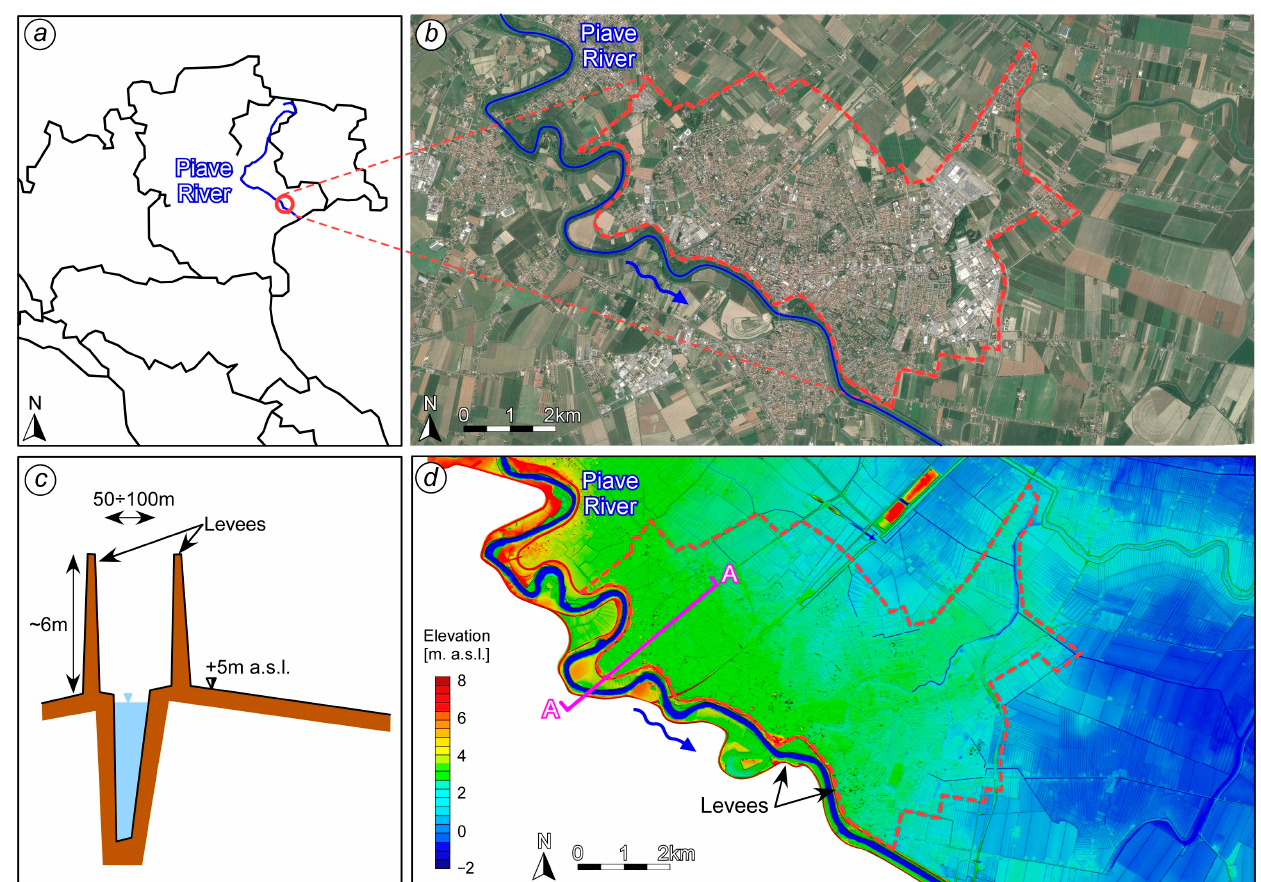
Figure 1. Study area: ( a ) location in the north of Italy; ( b ) aerial view of the study area in the San Donà di Piave Municipality with the course of the Piave River in blue; ( c ) schematic of cross-section A-A (out of scale); ( d ) the DTM with elevations in meters above the sea level (a.s.l.).